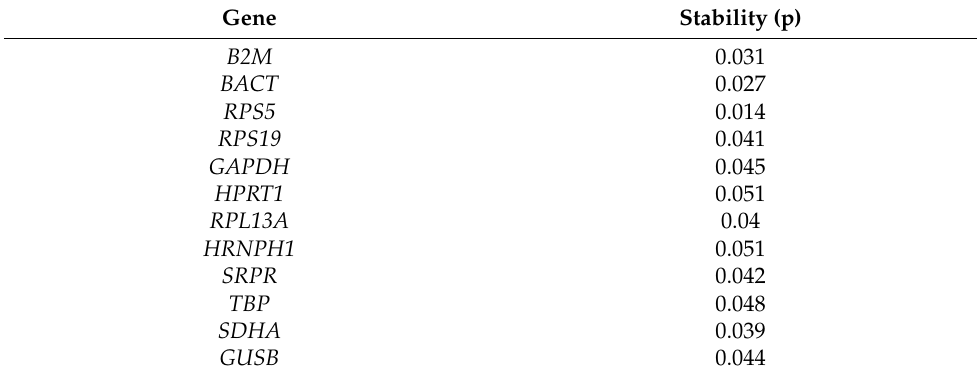
Table 4. Stability of reference genes (RG).